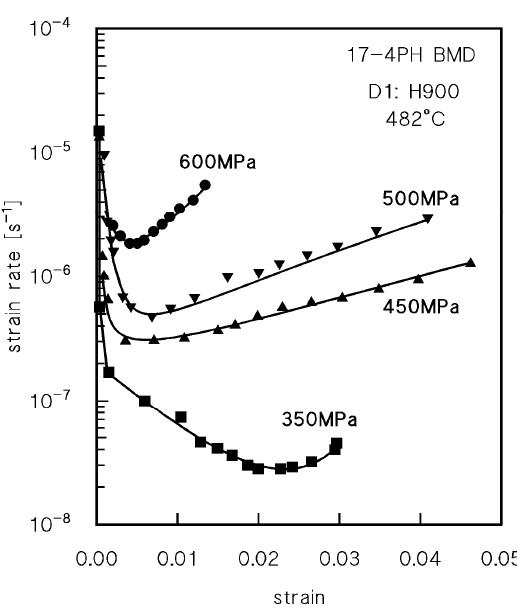
Figure 4. Creep curves (creep strain vs. creep strain rate) at 482 °C for D1